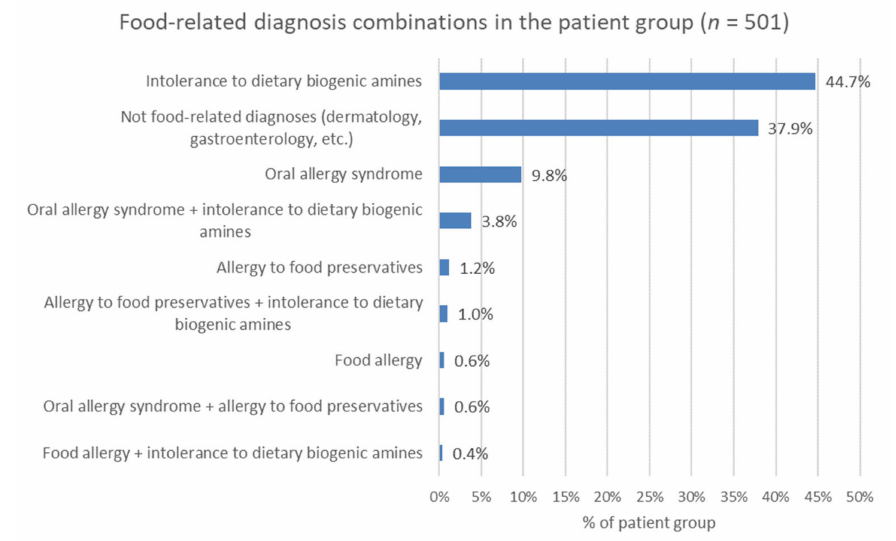
Figure 5. Food-related and non-food-related diagnosis combinations in patients with adverse food